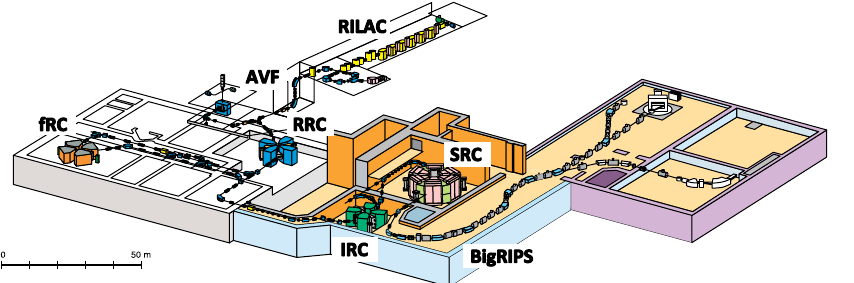
FIG. 1. Bird’s-eye view of RIBF. Two injectors, RIKEN linear accelerator (RILAC) and the AVF cyclotron (K70 MeV), are followed by four booster cyclotrons: RIKEN ring cyclotron [(RRC), K540 MeV], fixed-frequency ring cyclotron (fRC), intermediate-stage ring cyclotron (IRC), and superconducting ring cyclotron (SRC). The accelerated beams are transported to an in-flight RI beam separator